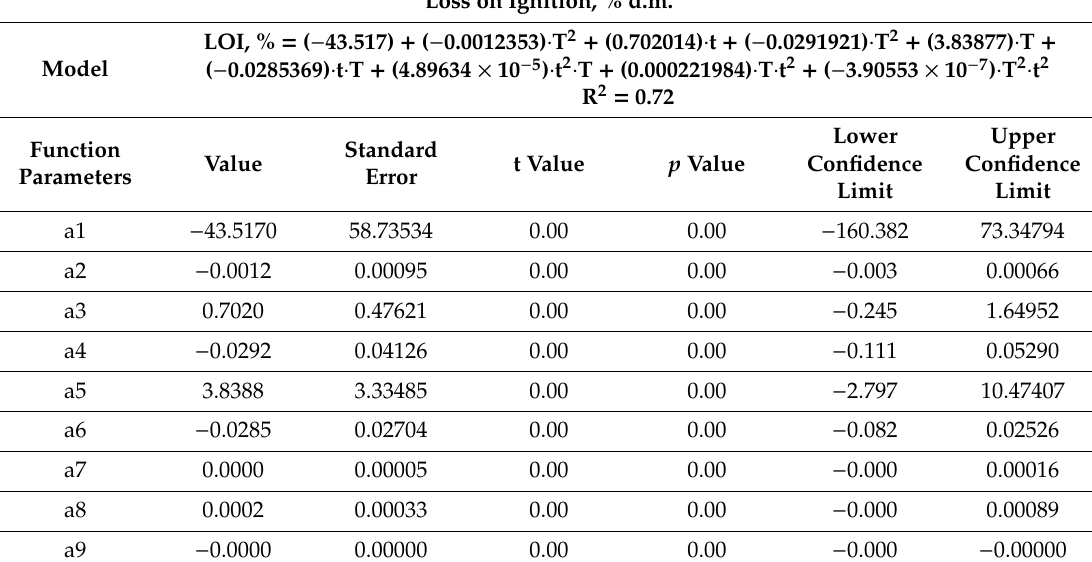
Table A3. The statistical parameters of polynomial regression analysis of the influence of SS torrefaction temperature and residence time on loss on ignition content in